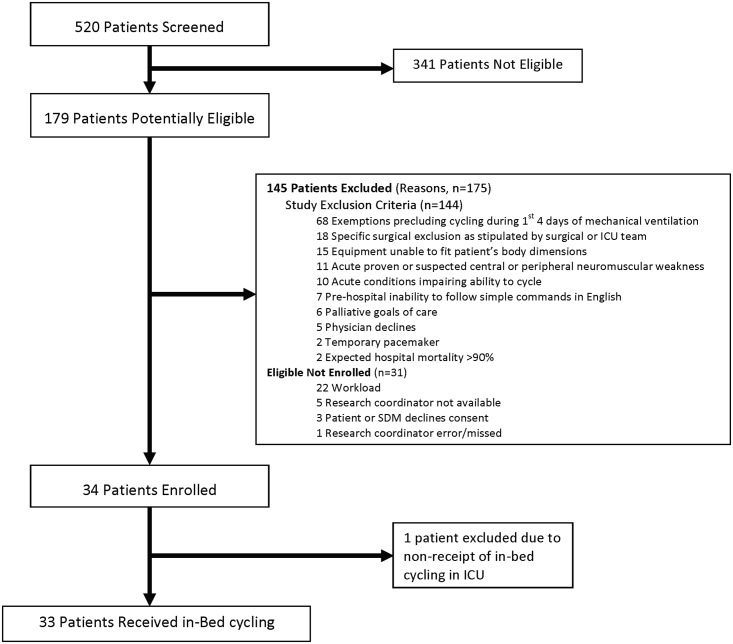
Patient flow diagram.This figure outlines patient screening and enrollment in the TryCYCLE study. The 68 persisting temporary exemptions within the first 4 days of mechanical ventilation included: receipt of neuromuscular blocking agents (n = 19), increase in vasoactive infusions (n = 14), femoral arterial or venous catheter in situ (n = 13), active myocardial infarction of unstable/ uncontrolled arrhythmia (n = 8), severe agitation (n = 2), persistent SpO2 <88% (n = 2), mean arterial pressure <60 mmHg or >110 mmHg (n = 1), heart rate <40 or >140 beats per minute (n = 1), other concern (n = 8).